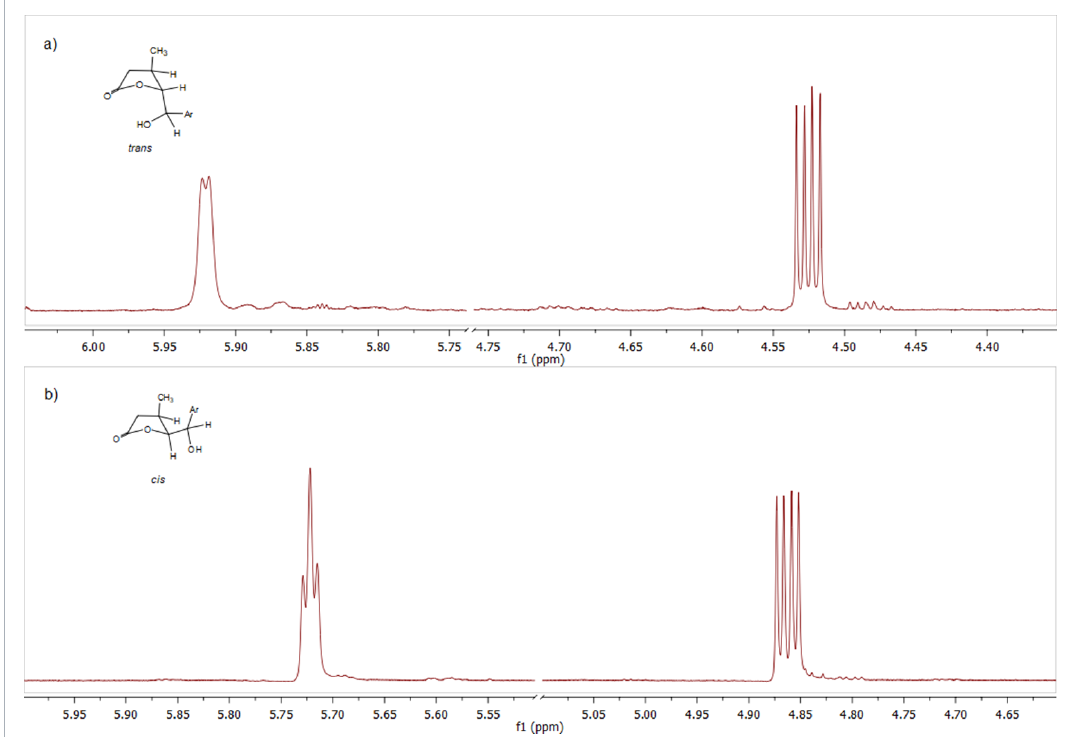
Figure 7. The comparison of the NMR signals for H-5 and H-6 protons of: ( a ) trans - δ -hydroxy- γ -lactone 12b ; and ( b ) cis - δ -hydroxy- γ -lactone 13a